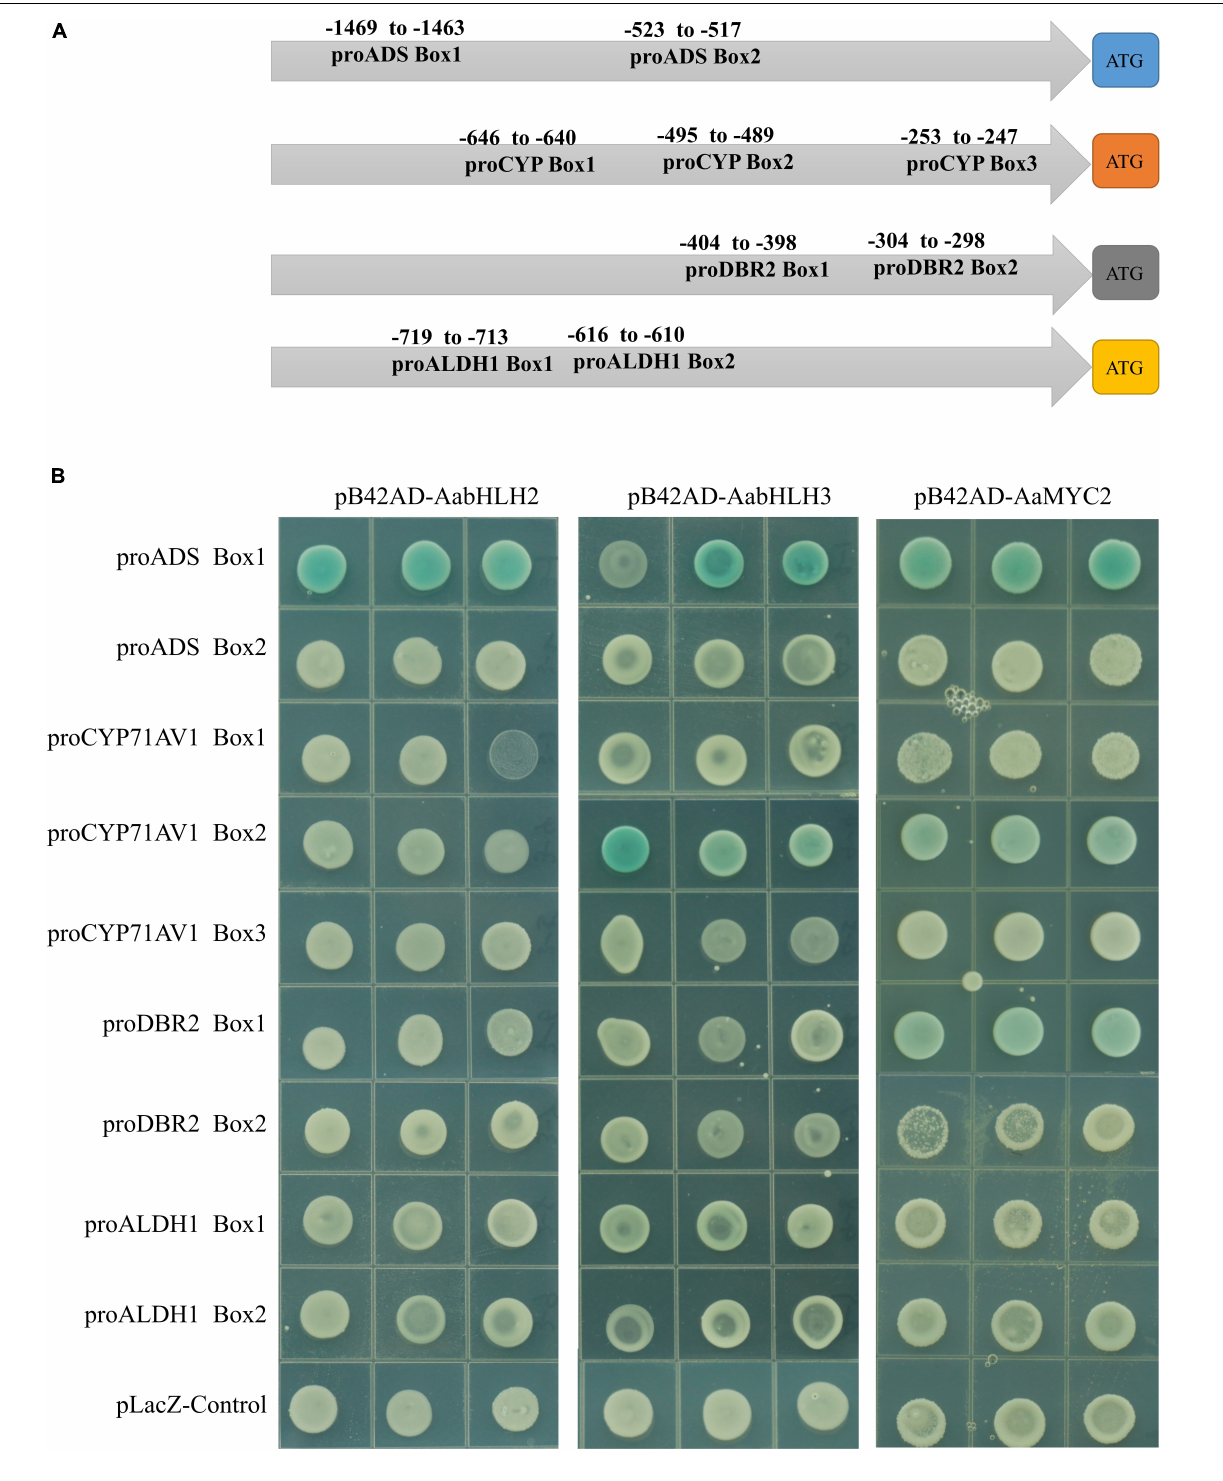
FIGURE 5 | Binding assay of AabHLH2 and AabHLH3 to G-box-like cis -elements in the promoters via yeast one-hybrid. (A) Schematic representation of all G-box-like cis -elements boxes position in the four pathway gene promoters. (B) The result of yeast one-hybrid assay for the interaction between AabHLH2 and AabHLH3 with DNA